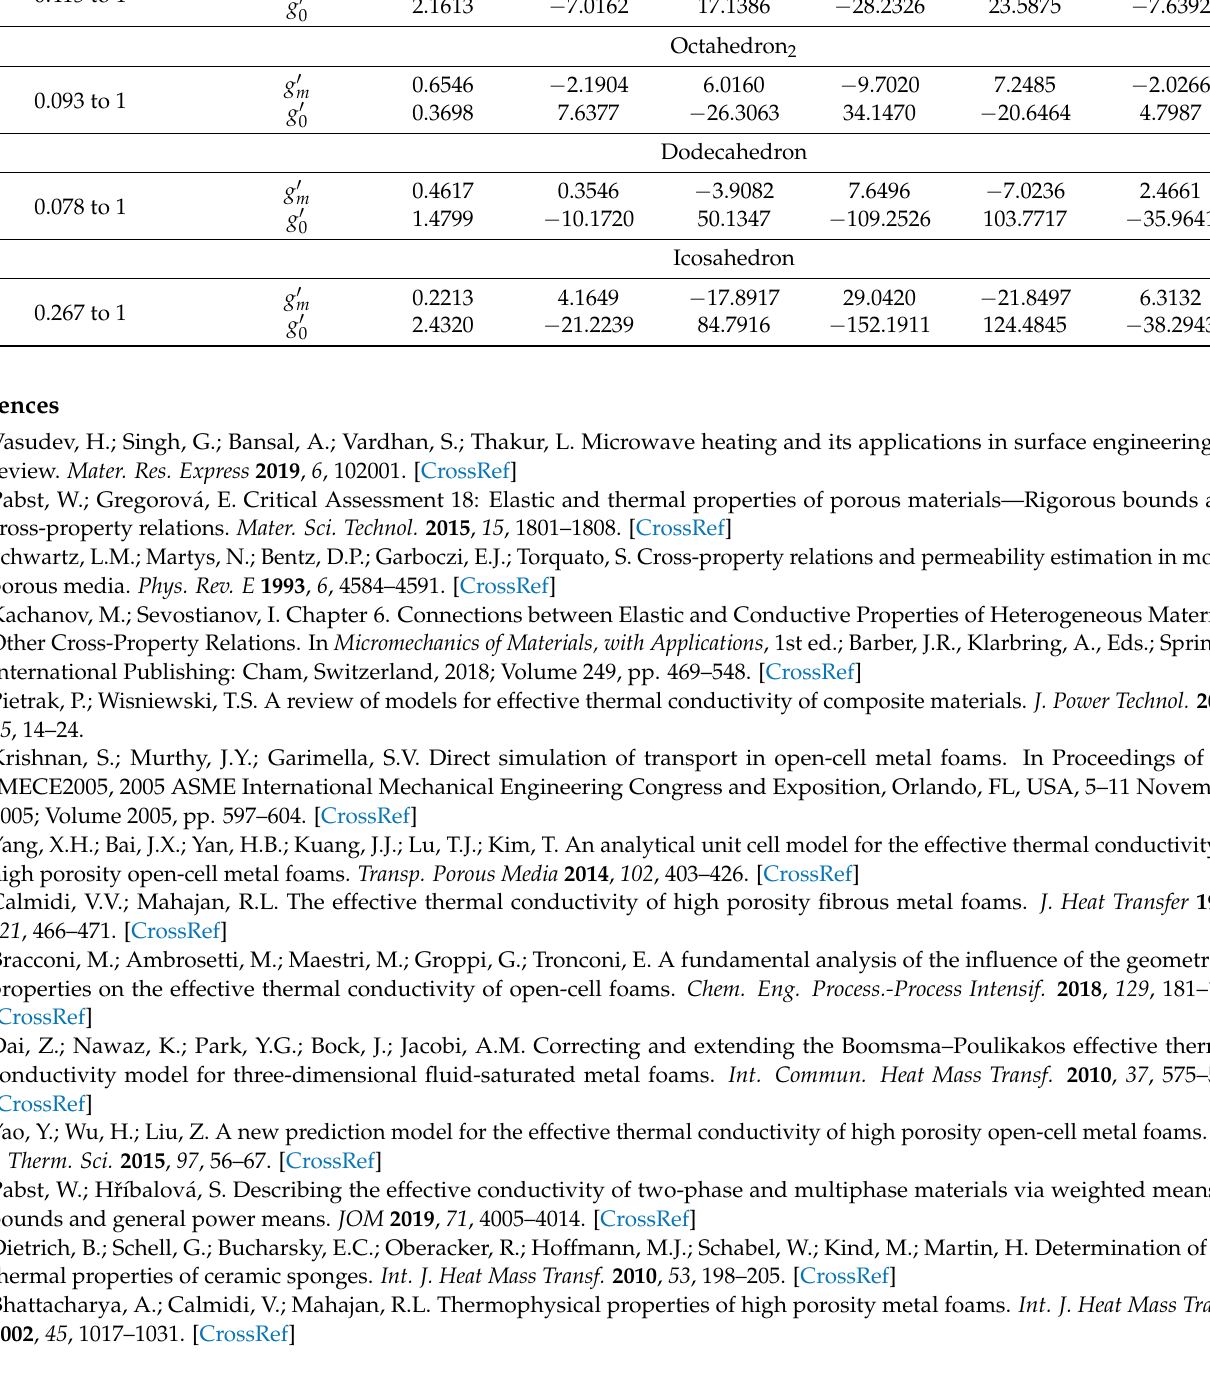
Table A1. Parameters used to calculate g (cid:48)